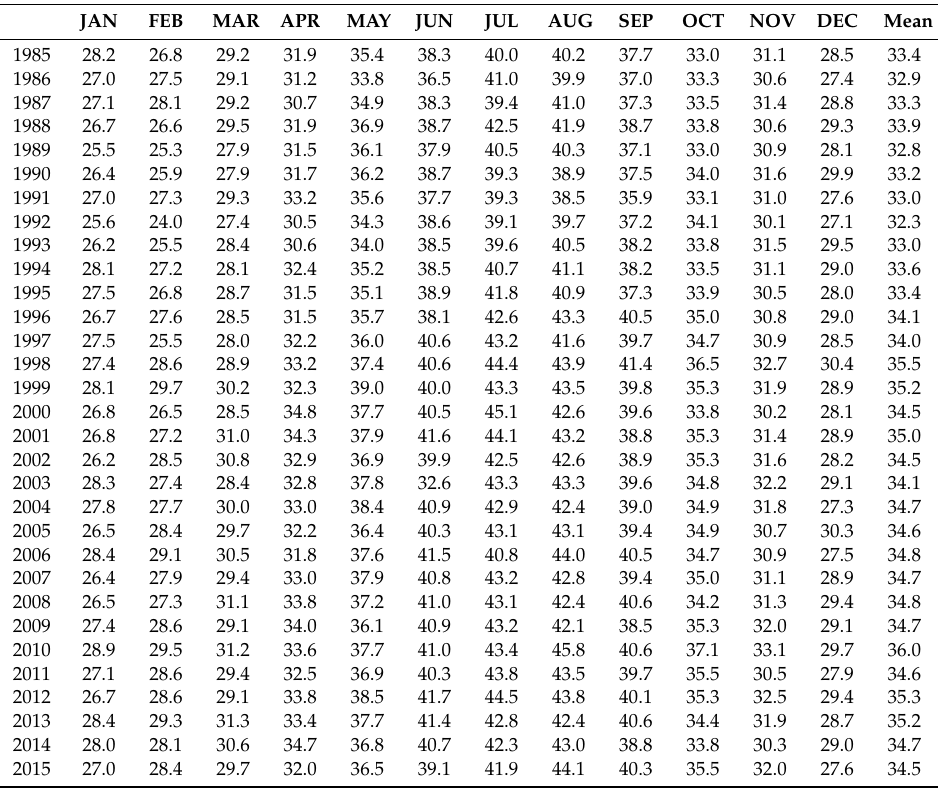
Table A1. Maximum temperature ( ◦